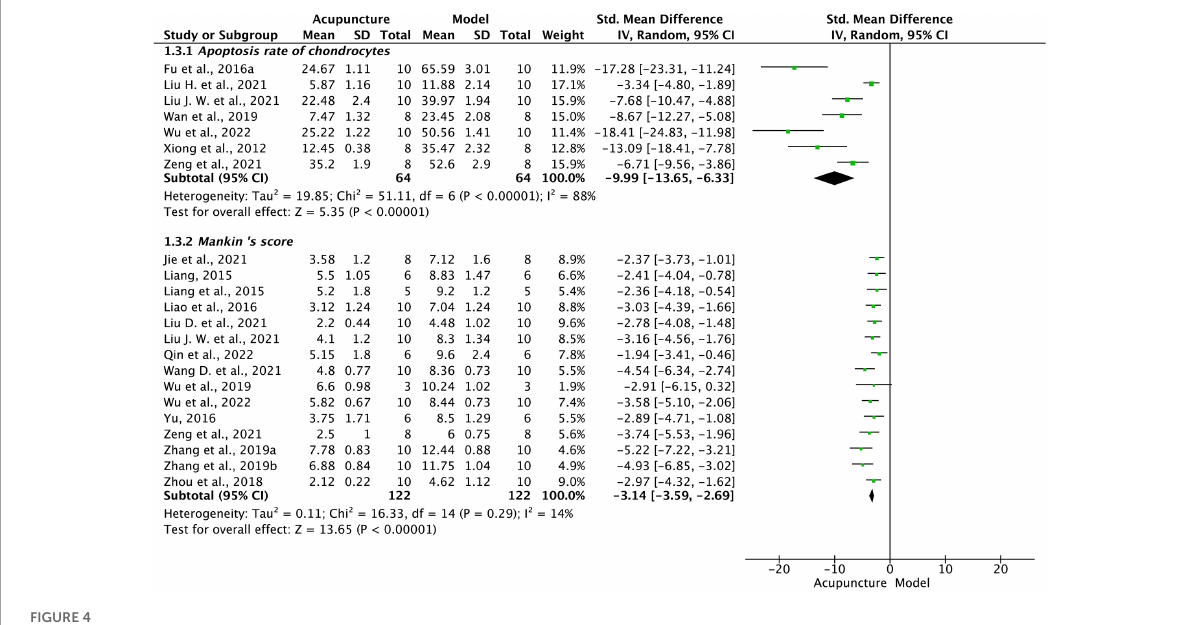
FIGURE4 Forest plot of apoptosis rate and Mankin’s